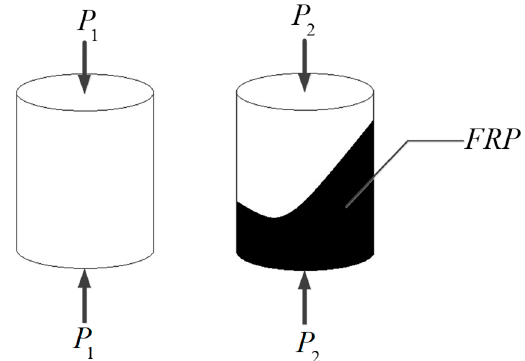
Figure 1. Two specimens (i.e., concrete cylinder and FRPCCC) subjected to the compression (an axial force).